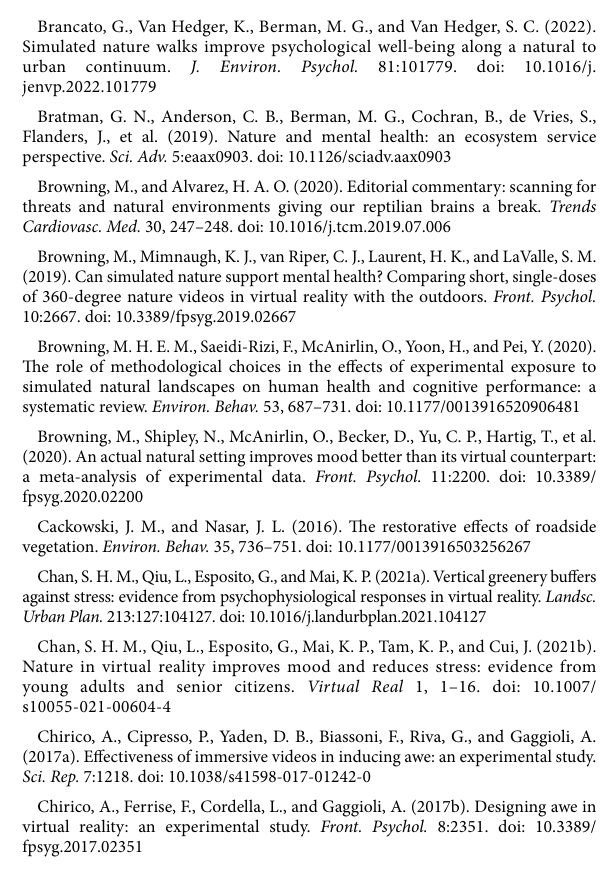
SUPPLEMENTARY FIGURE S1 Cochrane risk of Bias 2.0 table. SUPPLEMENTARY FIGURE S2 Subgroup analysis of the effects of simulated nature exposure on negative affect. SUPPLEMENTARY FIGURE S3 Subgroup analysis of the effects of simulated nature exposure on tension. SUPPLEMENTARY FIGURE S4 Subgroup analysis of the effects of simulated nature exposure on vigor. SUPPLEMENTARY FIGURE S5 Subgroup analysis of the effects of simulated nature exposure on calmness. SUPPLEMENTARY FIGURE S6 Funnel plot of positive affect. SUPPLEMENTARY FIGURE S7 Funnel plot of negative